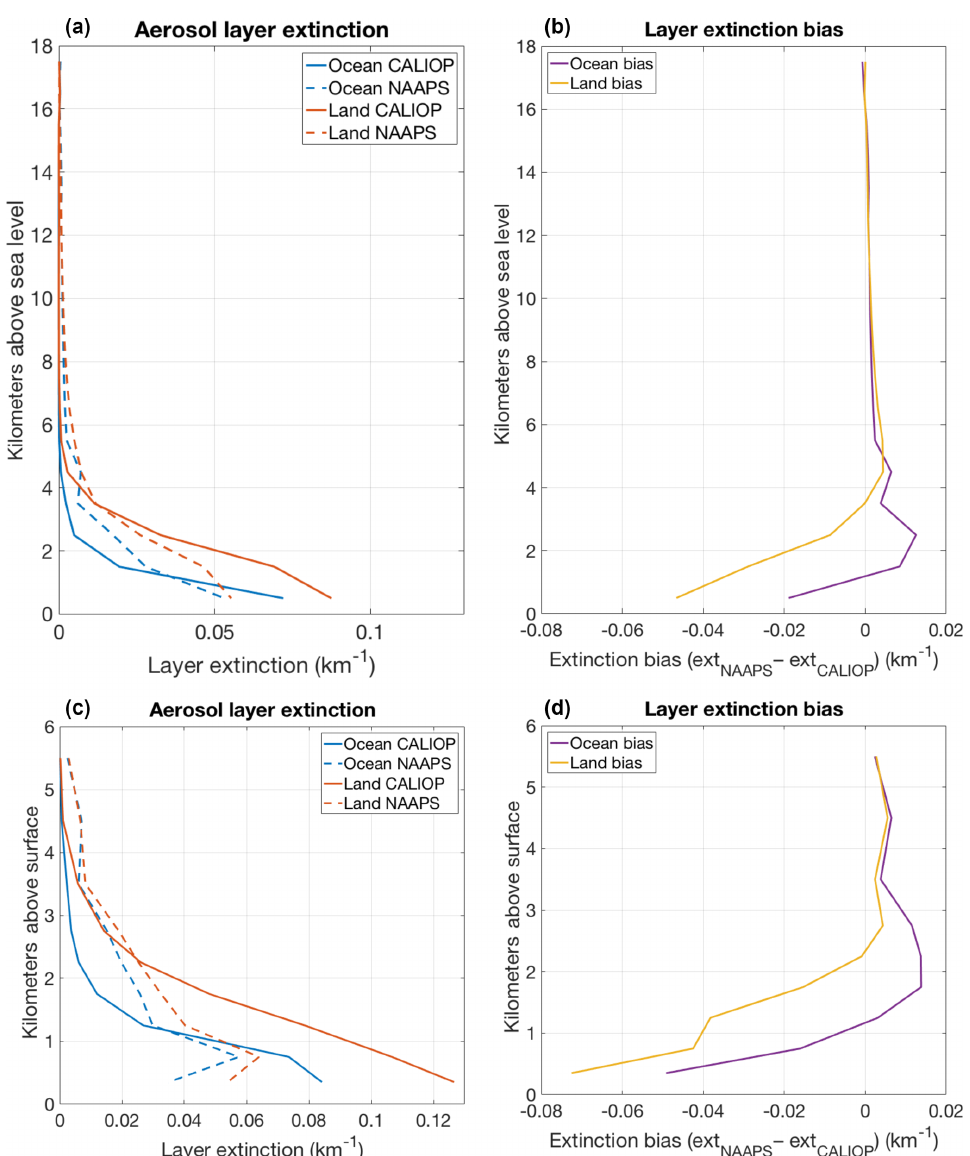
Figure 5. Vertical layer distributions of average CALIOP and NAAPS aerosol extinctions (a, c) and vertical distributions of CALIOP-NAAPS extinction bias (b, d) . Extinctions and extinction biases are shown for PBL layers (c, d) and MSL layers (a, b) . Layer extinction averages are for all SEA retrievals during 2006–2016. Only CALIOP cloud-cleared pixels and pixels where NAAPS and CALIOP detect positive total AOD are